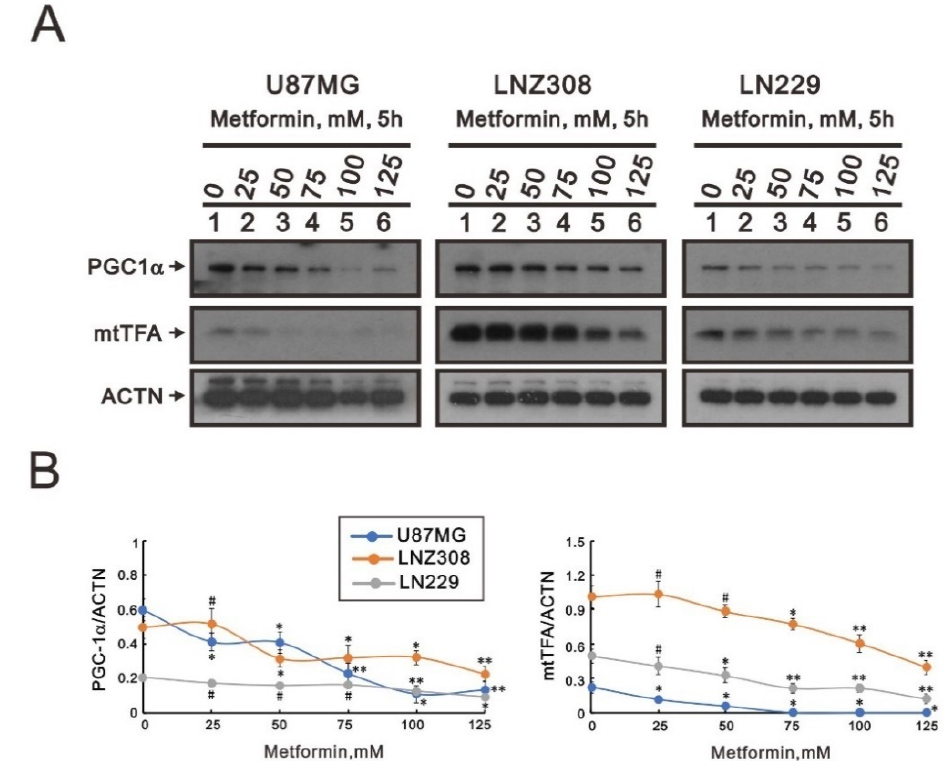
Figure 6. The effects of metformin on mitochondrial biogenesis in GBM cells. U87MG, LNZ308, and LN229 cells were treated with the indicated metformin concentrations. After 5 h, cell lysates were collected and subjected to ( A ) Western blotting analysis using antibodies against PGC-1 α and mtTFA. ACTN was used as the protein-loading control. The protein bands were quantified through pixel density scanning and evaluated using ImageJ, version 1.44a (http://imagej.nih.gov/ij/) (accessed on 15 July 2022). ( B ) The ratios of PGC-1 α /ACTN and mtTFA/ACTN were plotted in the U87MG, LNZ308, and LN229 cells. The results are representative of three independent experiments. # p > 0.05, * p < 0.05, and ** p < 0.01.